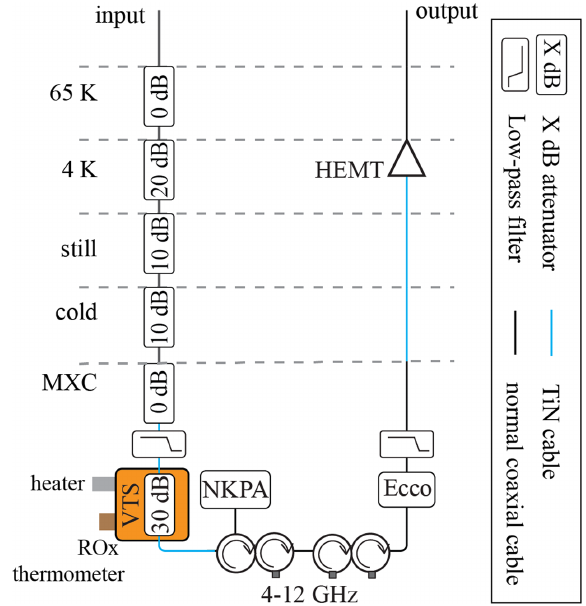
FIG. 4. Full diagram of the cryogenic circuit for NKPA char- acterization. The double pump and signal tones are combined and at room temperature and then sent to the input port. The VTS serves as an absolute noise power reference. Isolators are inserted between the NKPA and the HEMT amplifier to suppress backward propagating signals. “Ecco” represent eccosorb